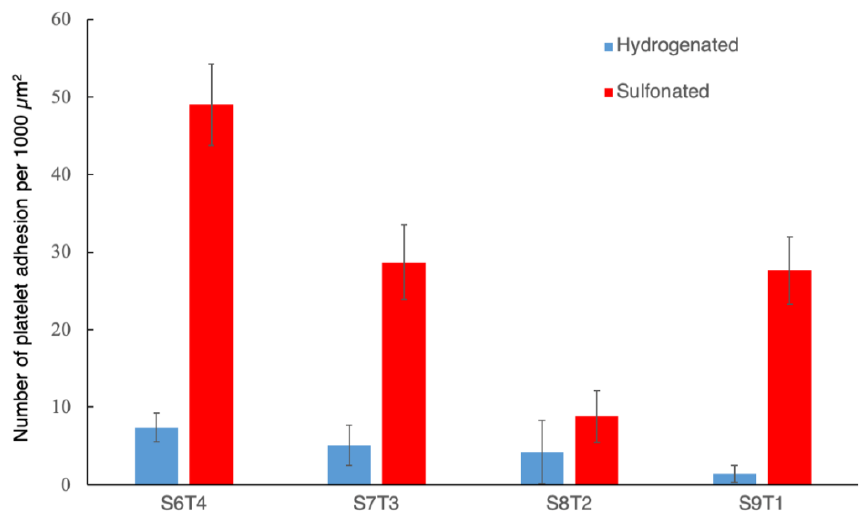
Figure 8. Platelet adhesion density on the hydrogenated and sulfonated block copolymers.